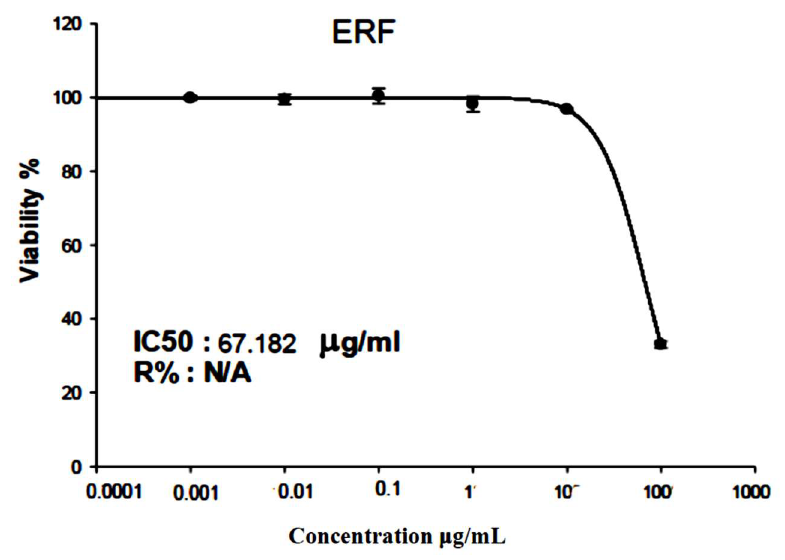
Figure 6. SRB assay on HepG2 cells to validate the ERF impact on the cell viability after 72 h.